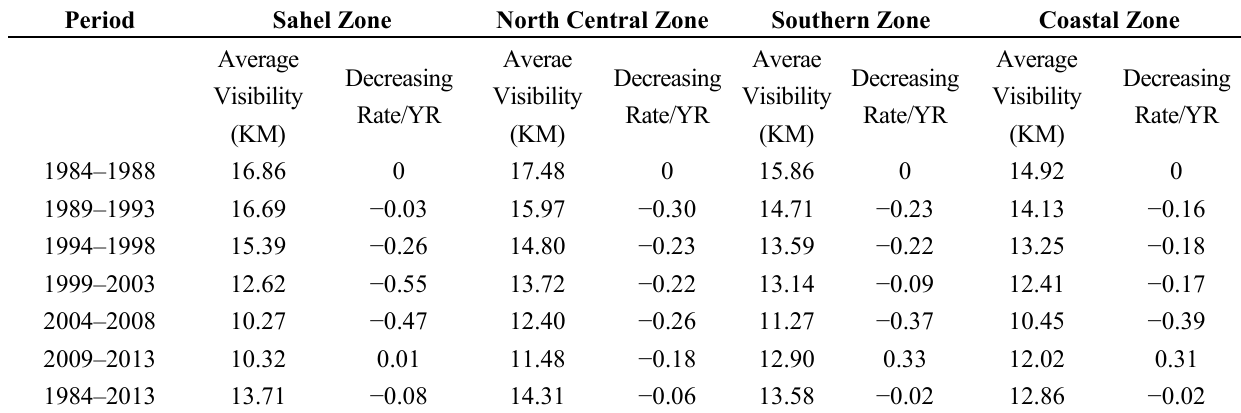
Table 4. The five years interval average visibility for all the zones of Nigeria. Period Sahel Zone North Central Zone Southern Zone Coastal Zone Average